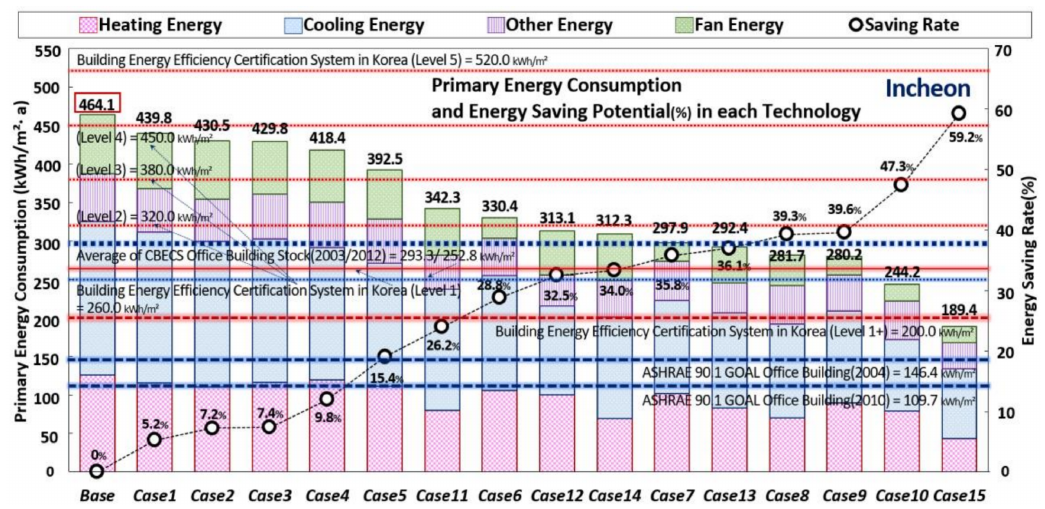
Figure 18. Primary energy consumptions and energy saving potential in each technology